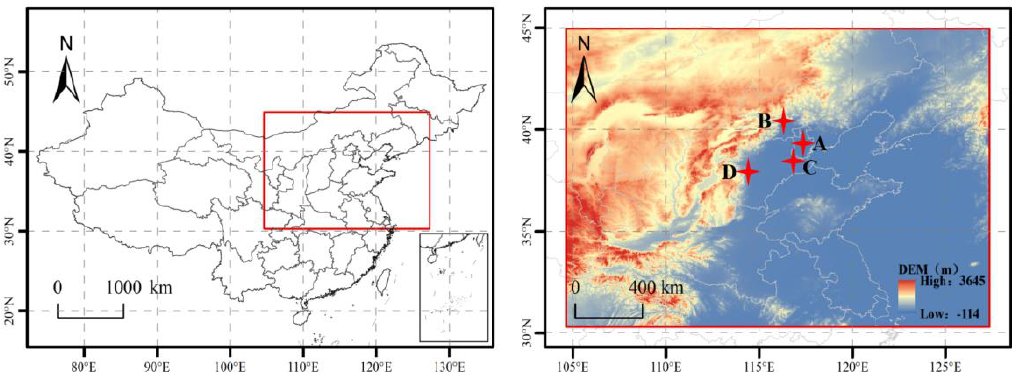
Figure 1. Study domain and terrain height in the domain.